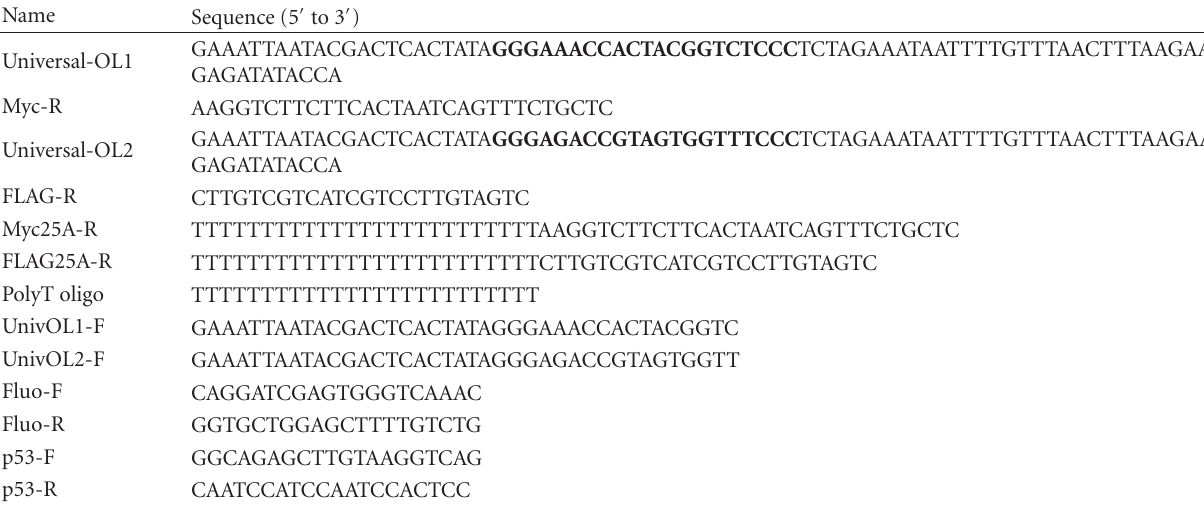
Table 1: Oligonucleotide